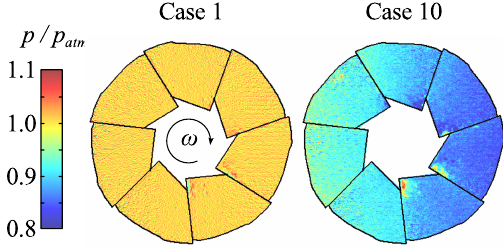
Figure 13. Pressure from scanning measurements for cases 1 and 10, i.e. , with the impeller at